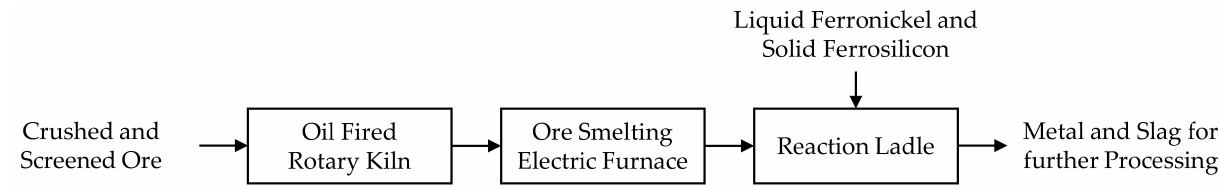
Figure 11. Simplified process of the Hanna Nickel smelting operation (after